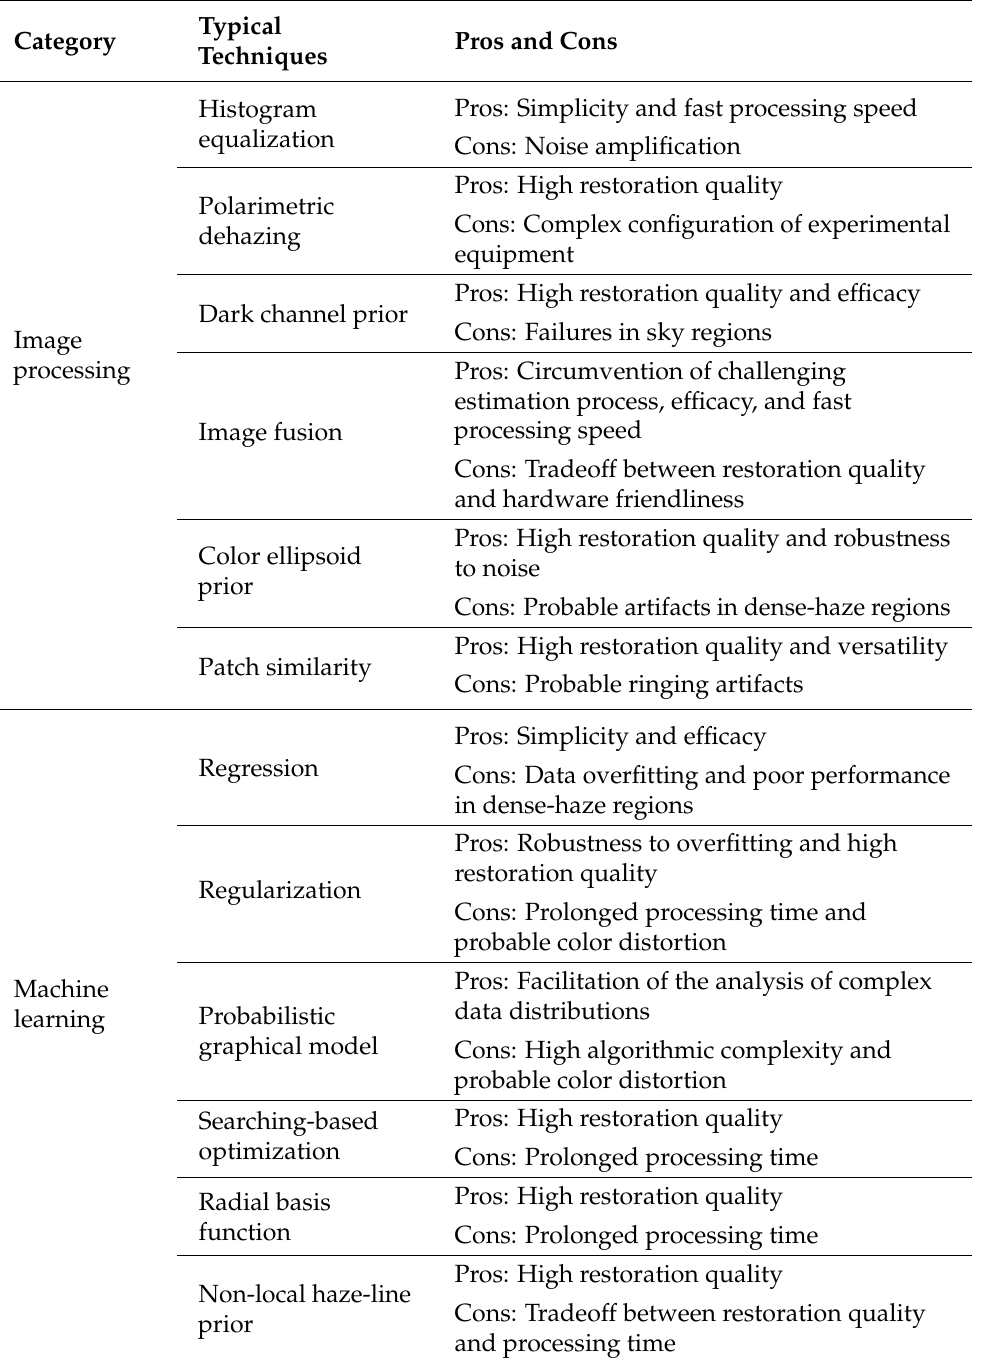
Table 1. Summary of visibility restoration algorithms in the